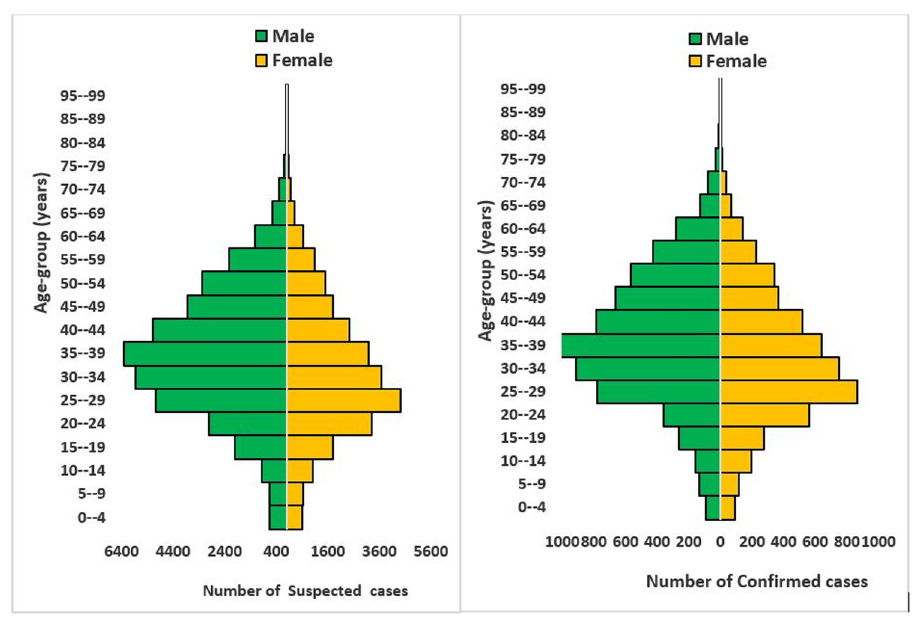
Fig 5. Age-sex distribution of COVID-19 cases in FCT from March 2020-January 2021.